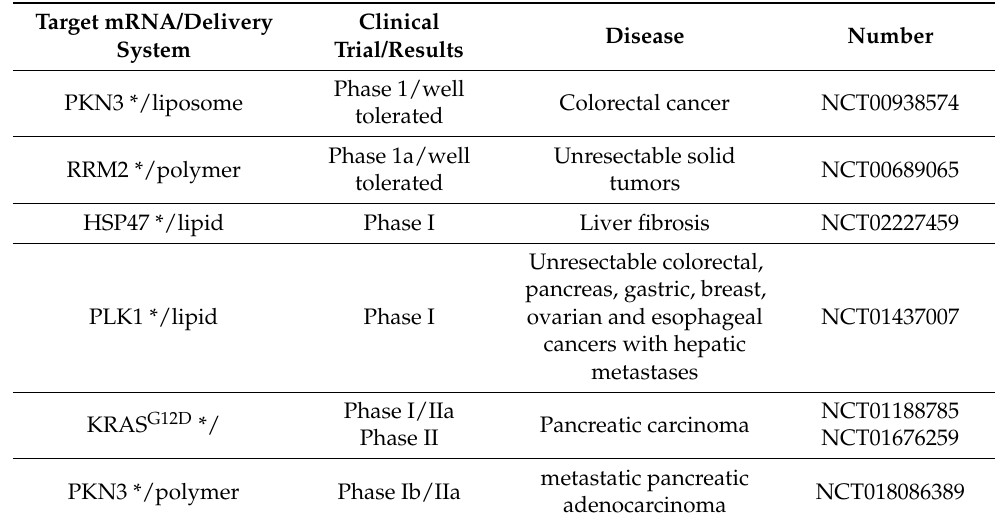
Table 7. siRNA in clinical